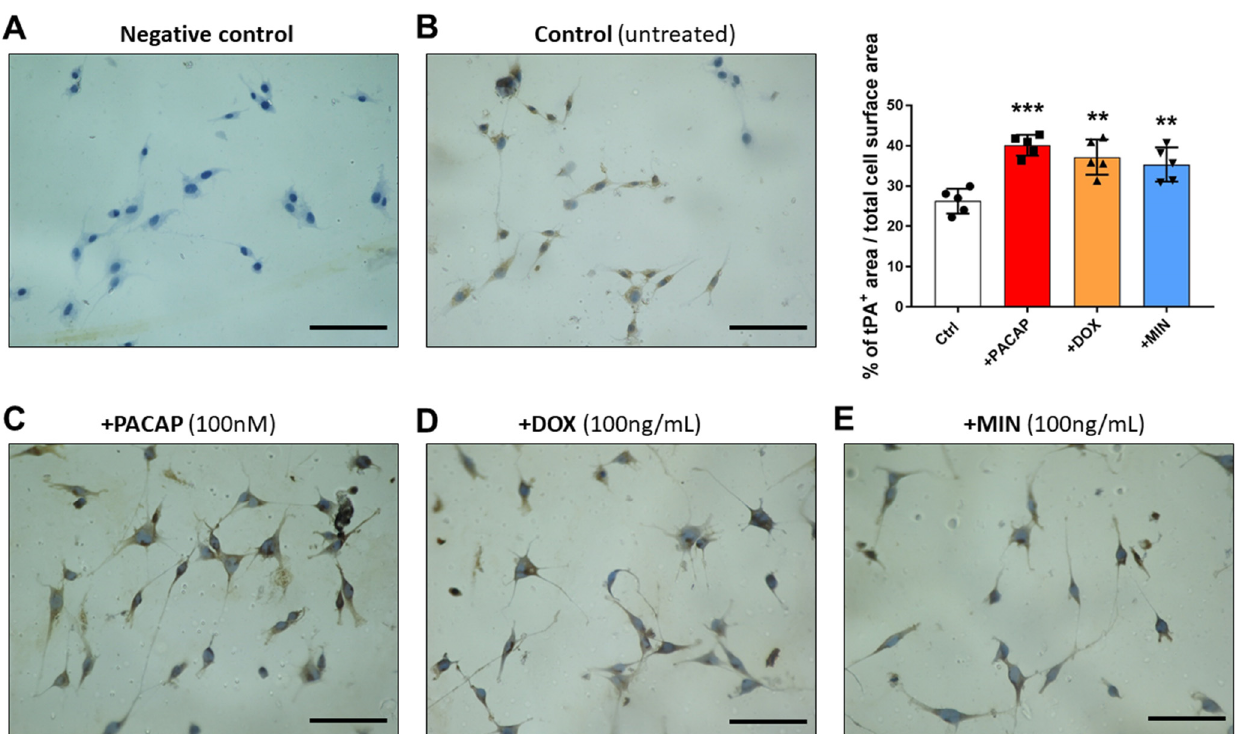
Figure 4. Immunocytochemistry of tPA in RT4 cells exposed to PACAP, doxycycline or minocycline. Representative cytochemistry images showing tPA immunoreactivity in ( A ) negative control (no primary Ab), ( B ) untreated, ( C ) PACAP treated, ( D ) doxycycline treated and ( E ) minocycline treated RT4 cells. Values are reported as percentage of tPA-positive cell surface area normalized to total cell surface area ± S.E.M. ** p < 0.01 or *** p < 0.001, as determined by ANOVA followed by Dunnett’s post-hoc test. Magnification = 20×. Scale bar = 60 μ m.